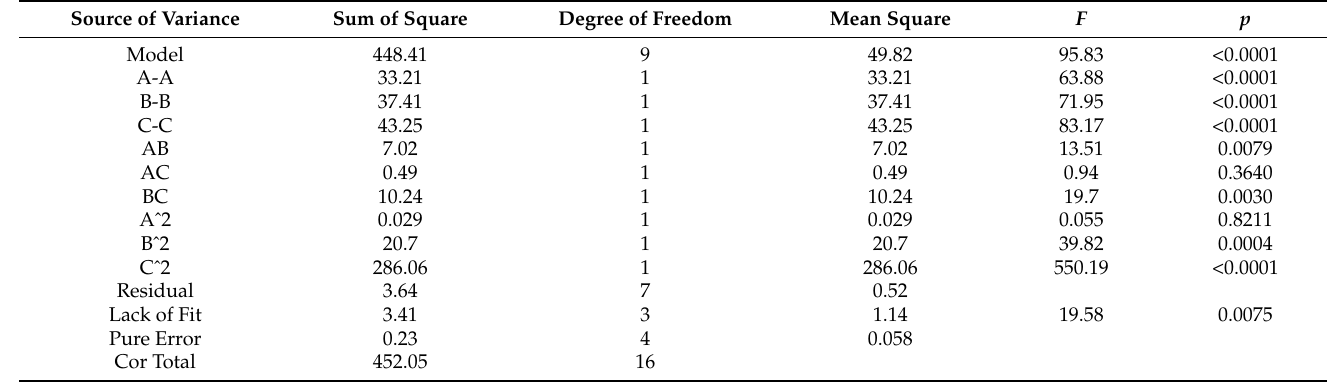
Figure 20. Interaction between forward speed and wind velocity of blowers.